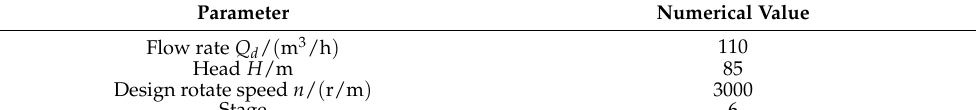
Table 1. The performance geometric parameters of the multiphase pump.